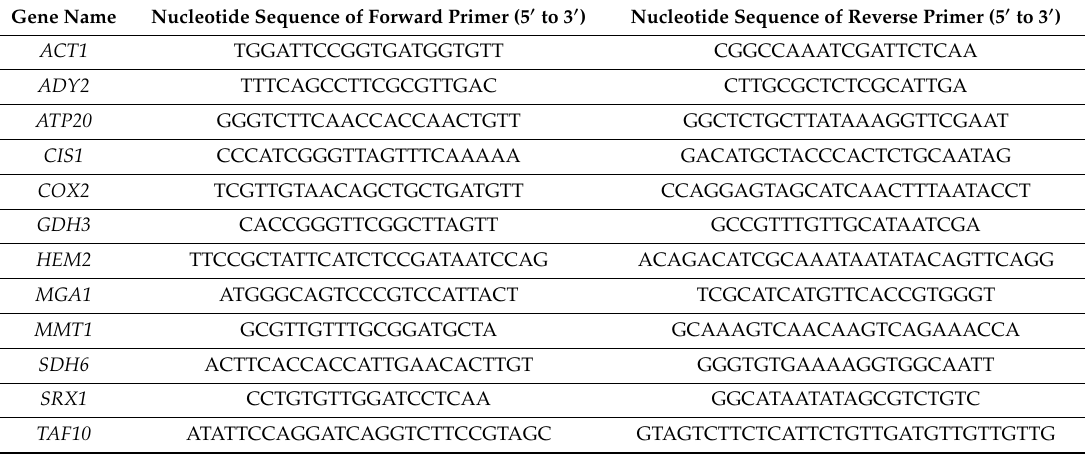
Table 1. Primers used in this study for the analysis of gene expression by